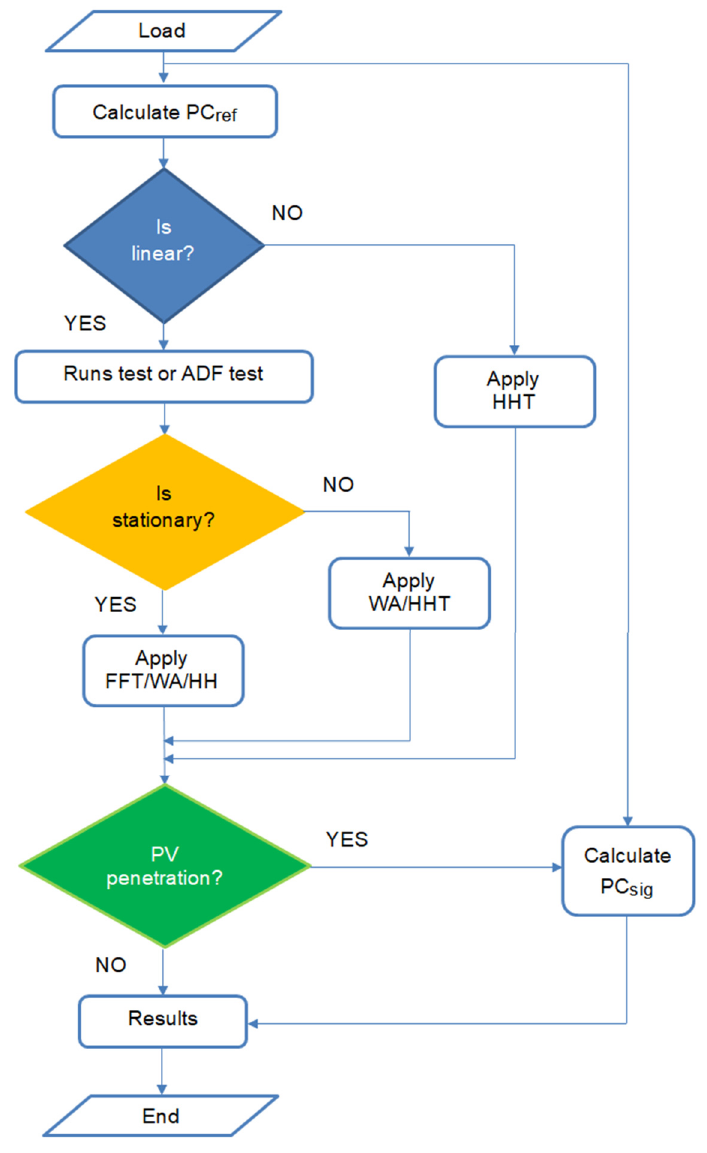
Figure 1. Flow-chart to choose the most suitable Figure 1. Flow ‐ chart to choose the most suitable method.